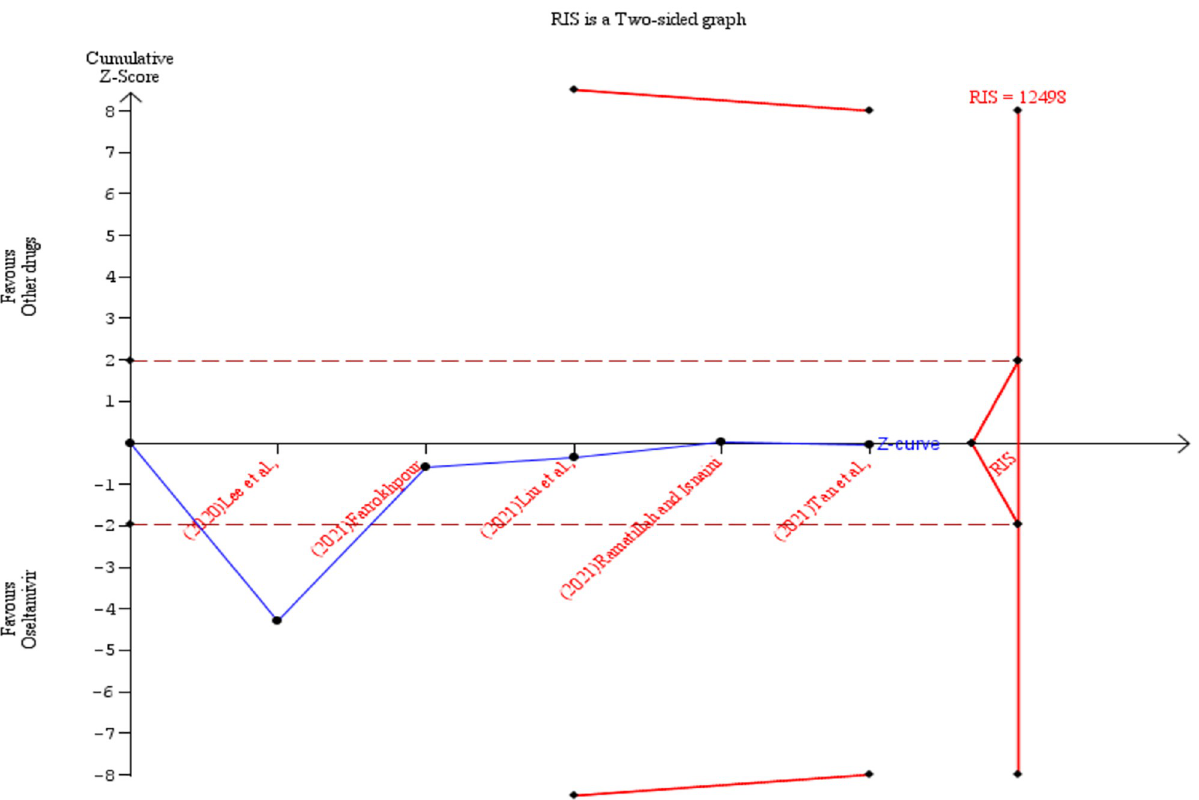
Fig 13. Post-hoc analysis. Shows the trial sequential analysis result comparing the survival of COVID-19 patients treated with oseltamivir versus other